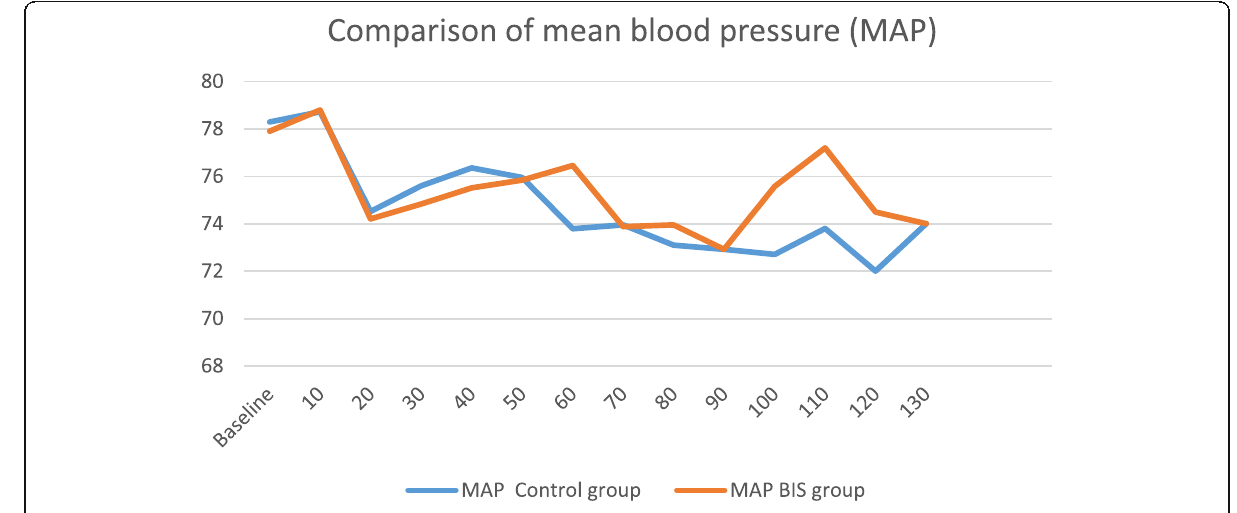
Fig. 3 Comparison of mean blood pressure (MAP) between the control group and BIS